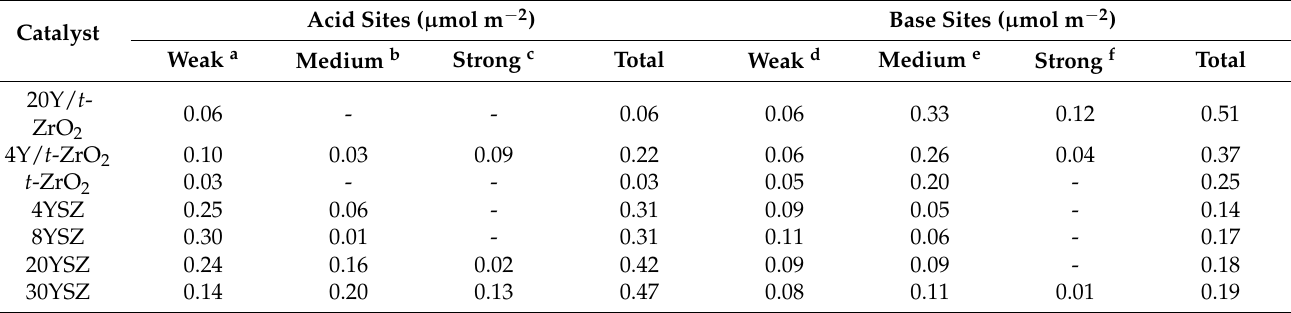
Table 1. Density of acid and base sites for all of the tested